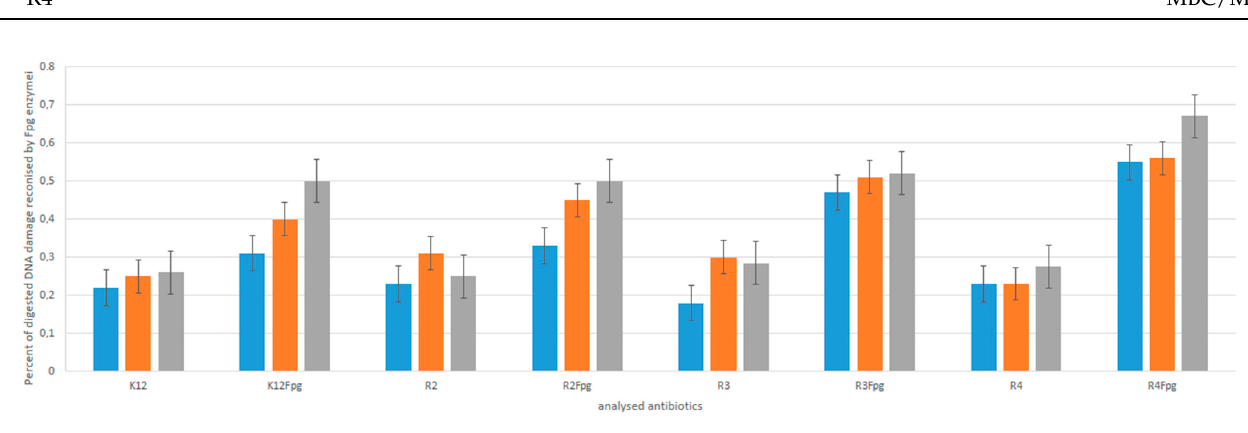
Table 3. Statistical analysis of all analyzed compounds by MIC, MBC, and MBC/MIC; <0.05 *, <0.01 **, <0.001 ***.